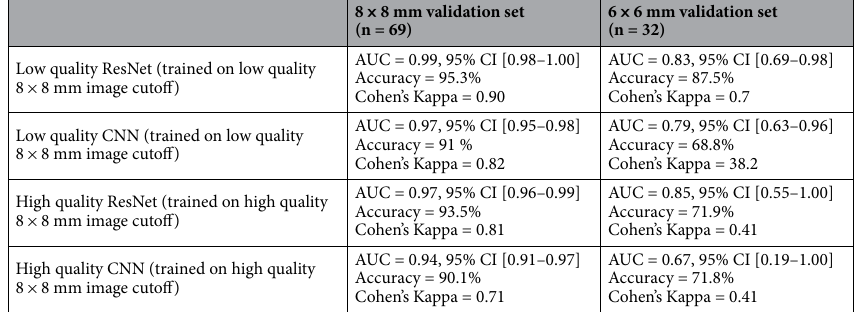
Low quality ResNet (trained on low quality 8 × 8 mm image cutoff)